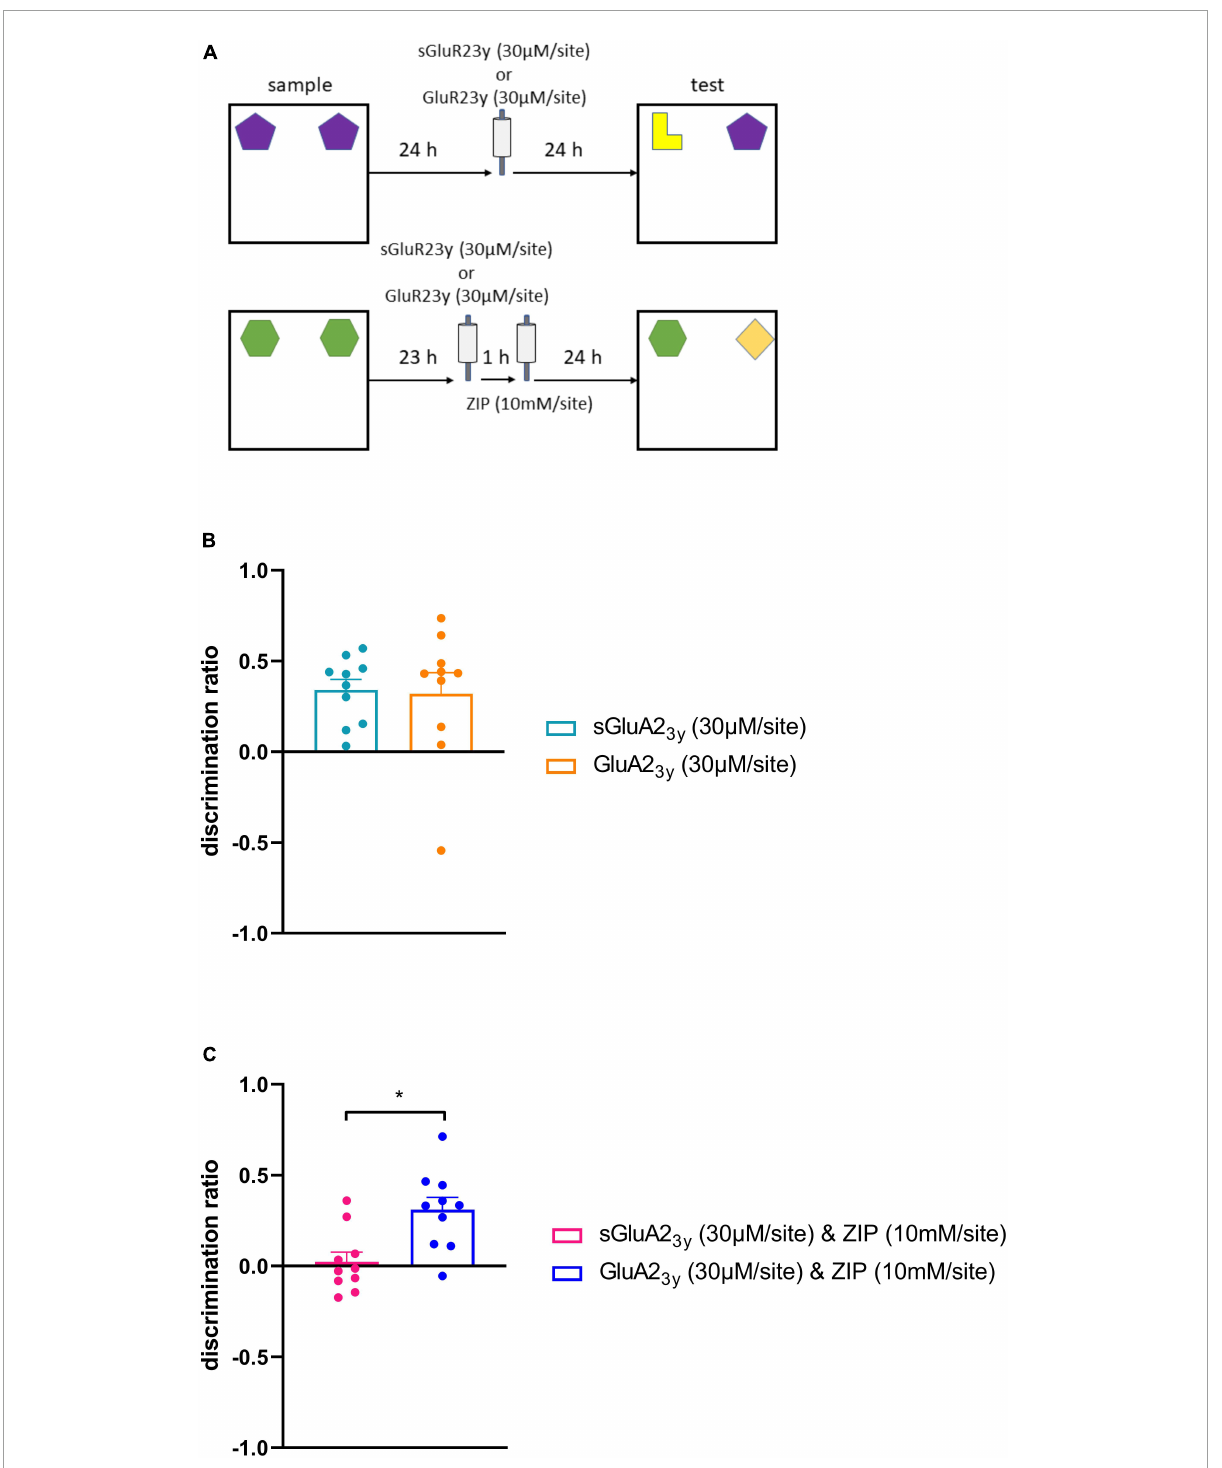
FIGURE3 Blocking AMPA receptor endocytosis prevents the impairment in object recognition memory maintenance by intra PRH infusion of ZIP. (A) Outline of object recognition task and infusion timings, in the first experiment sGluA23y or GluA23y was infused 24 h after the sample phase, in the second experiment infusion of sGluA23y/GluA23y occurred 23 h after the sample phase, 1 h after this infusion ZIP was infused. (B) Intra-PRH GluA23y did not alter NOR memory maintenance. (C) Infusion of GluA23y into PRH prevented the impairment in NOR maintenance produced by intra-PRH ZIP. Data presented as mean ± sem, all conditions n = 10, * p <